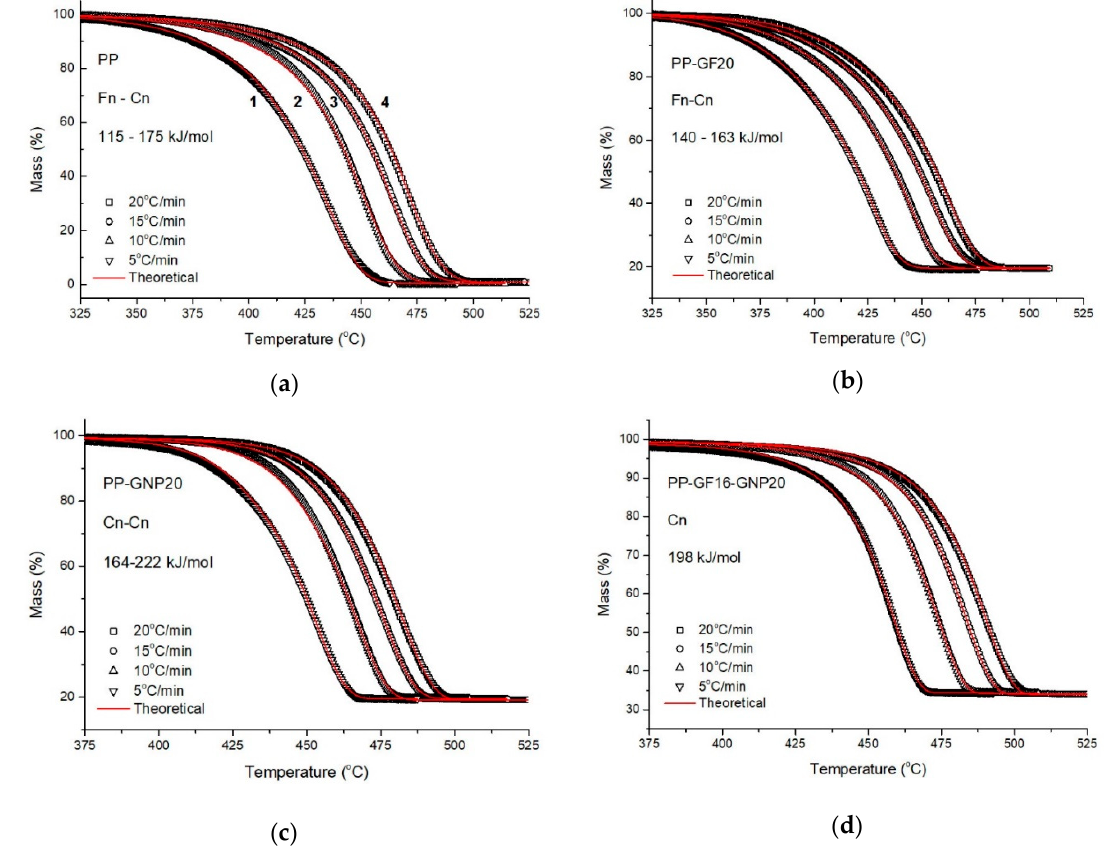
Figure 10. Thermal degradation of ( a ) PP, ( b ) PP–GF20, ( c ) PP–GNP20, and ( d ) PP–GF16–GNP20 composites at different heating rates ( 1 ) 5 °C/min, ( 2 ) 10 °C/min, ( 3 ) 15 °C/min, ( 4 ) 20 °C/min. The open black symbols represent the experimental data, while the continuous red lines represent the fittings with different models. Table 1. Calculated values of activation energy (E), pre-exponential factor (A), reaction order (n), branching rate constant (K cat ) and correlation coefficient (R 2 ) for PP and the composites.